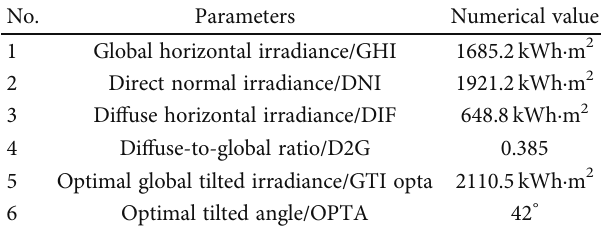
Figure 3: Global horizontal irradiance. Table 3: Table for the parameters of optical resources.